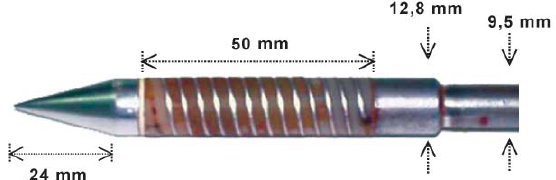
Figura 2. Sonda espiral de TDR posicionada acima do cone da haste de